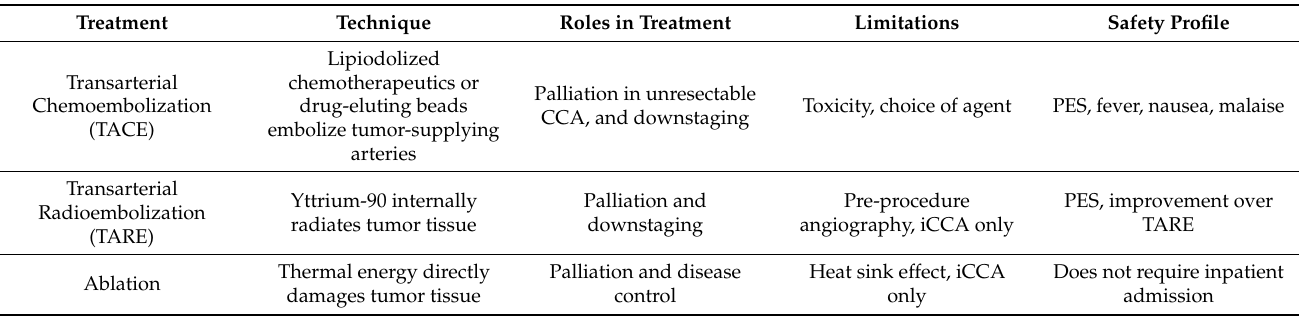
Table 1. Overview of current locoregional